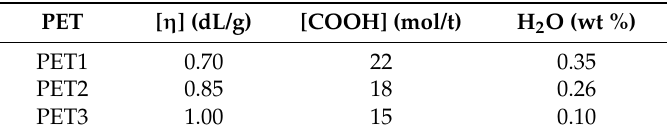
Table 1. The properties of the PET chips.